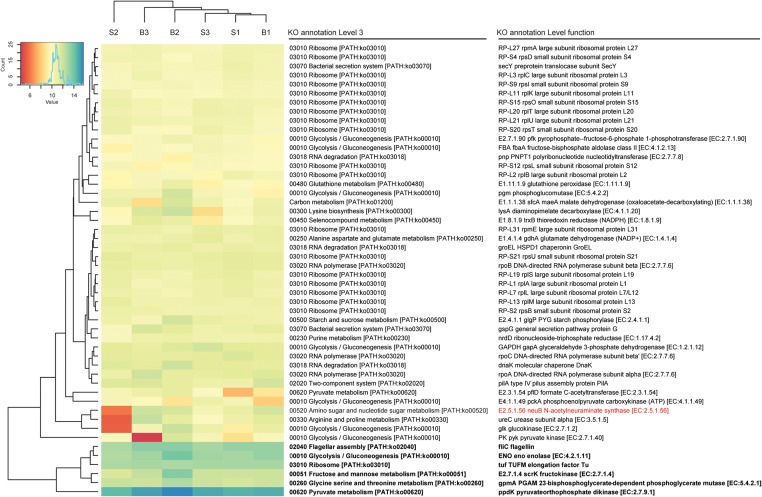
Functional bacterial hits. The 50 most abundant features of the KO annotation are listed. Read count values are given as transformed log2 values of normalized counts per feature. Based on the dendrogram’s branching hierarchy, a ‘high abundance cluster’ was defined and marked in bold. Statistically significant differences of features between baseline (B1–B3) and SARA (S1–S3) replicates were colored red.